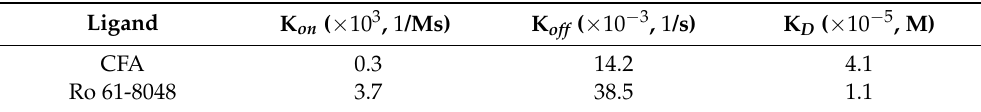
Figure 6. SPR binding of CFA and Ro 61-8048 to KMO. The sensorgrams display the binding reaction over time for ( A ) CFA (10, 19, 38, 150, and 300 µ M) and ( B ) Ro 61-8048 (1, 3, 10, and 20 µ M). Table 4. Association ( K on ) rate, dissociation ( K of f ) rate, and dissociation constant ( K D ) for CFA and Ro 61-8048.